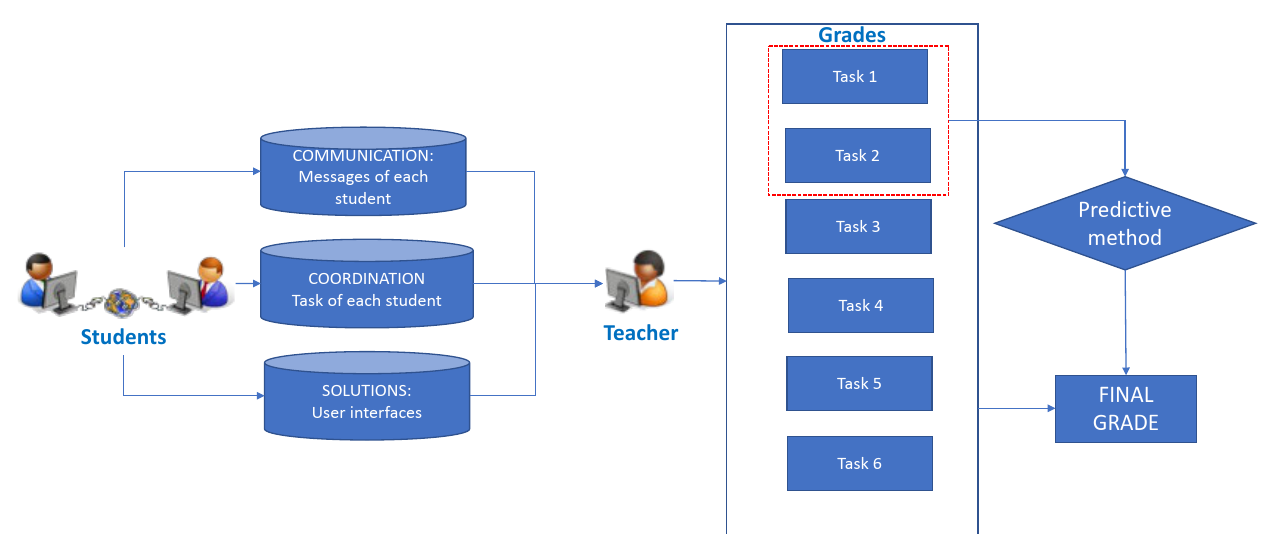
Figure 2. Outline of the process followed to experiment with the